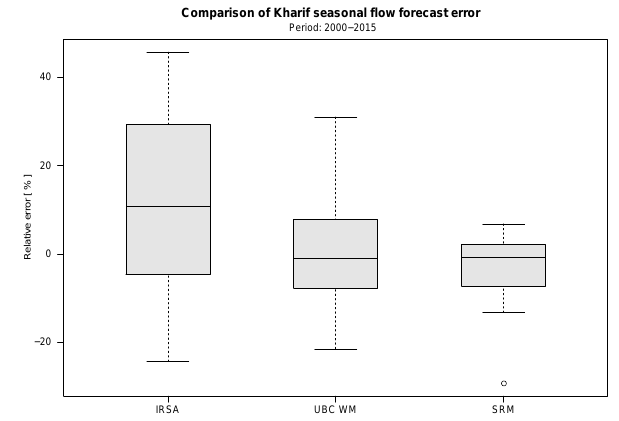
Figure 5. Statistics of relative error of Kharif flow volume fore- casts by IRSA’s statistical approach, UBC watershed model, and SRM. SRM 2000–2011 are hindcasts, all other forecasts. The series include the approx. 200 years flood in